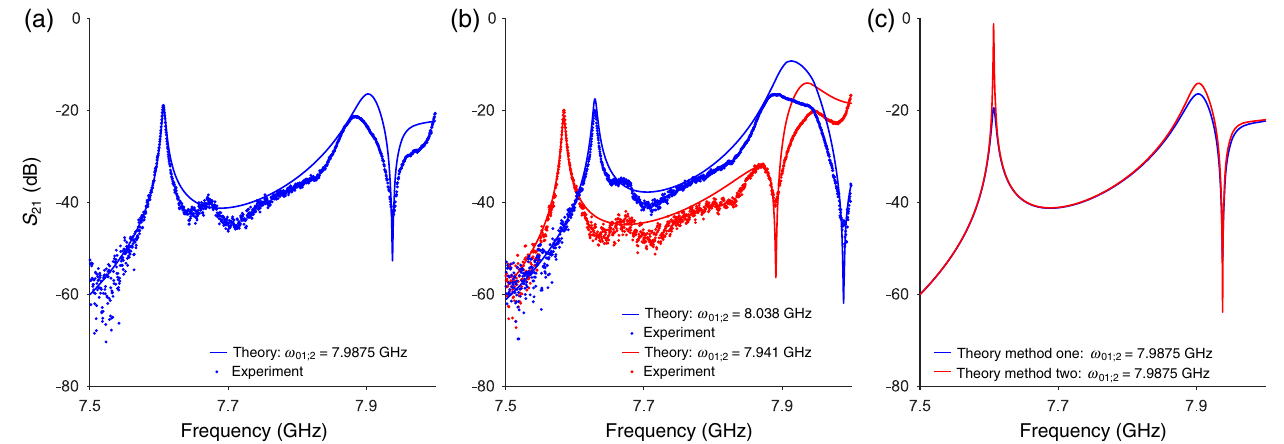
FIG. 6. Dependence of transmission S 21 on drive frequency, dependence used for determining the coupling strength of the second qubit, i.e., the one at site N= 2 þ 1 ¼ 9 . (a) Solid blue line is theoretical data for ω 01;2 ¼ 7 . 9875 GHz while blue dots are experimental data. We choose parameters of the Hamiltonian such that the bound-state frequency, the transmission dip frequency, and the linewidth of the bound state match the experimental data. (b) Solid blue line is theoretical data for ω 01;2 ¼ 7 . 941 GHz and blue dots are experimental data. Solid red line is theoretical data for ω 01;2 ¼ 8 . 038 GHz and red dots are experimental data. (c) Comparison of transmission methods for ω 01;2 ¼ 7 . 9875 GHz. The solid blue line is from method one, while the solid red line is from method two. The bound-state and transmission dip occur at the same frequencies for both